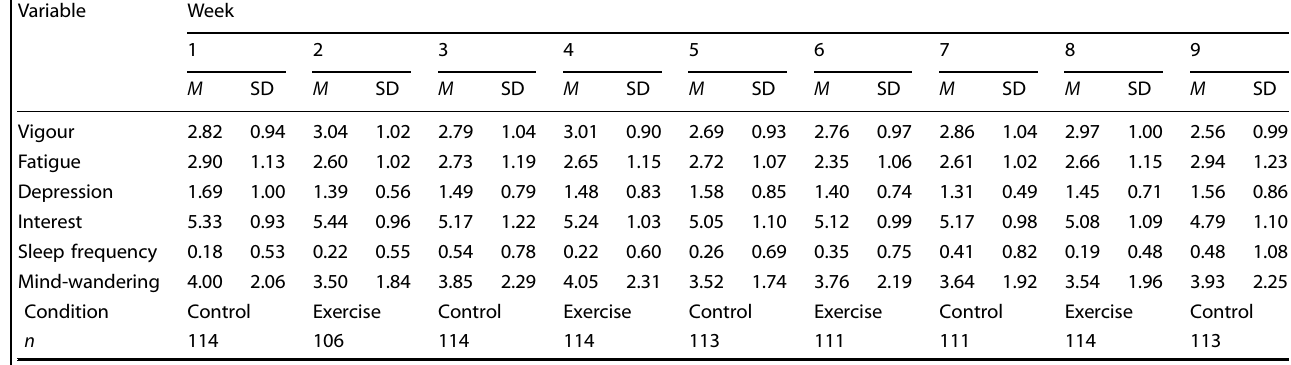
Table 1. Descriptive statistics of variables.